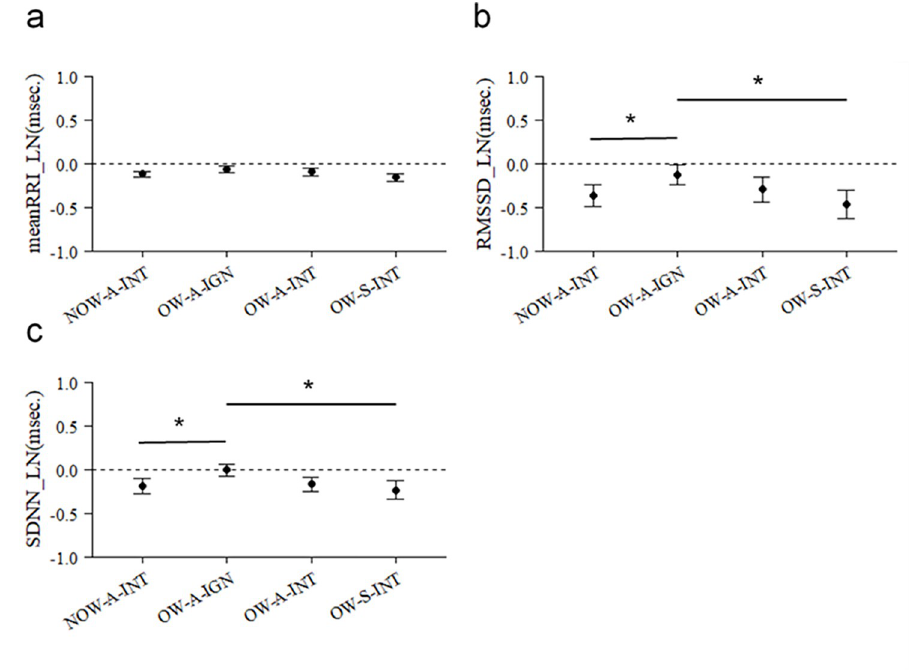
Fig 3. Comparison between each video stimulus on the HRV index. a mean RRI; b RMSSD; c SDNN are shown. The black circle represents the average value. Error bars represent standard errors (paired t-test: � p < 0.05).